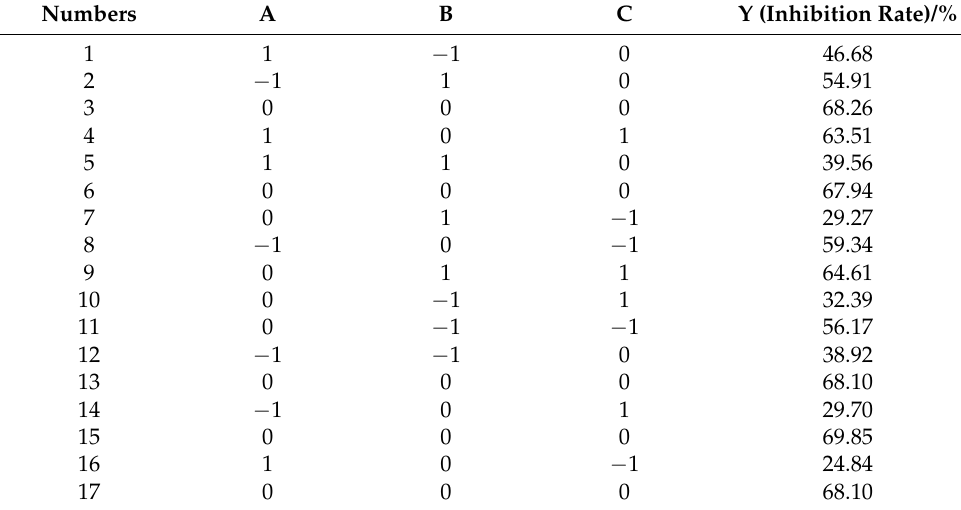
Table 5. Box–Benhnken experimental design and response value.